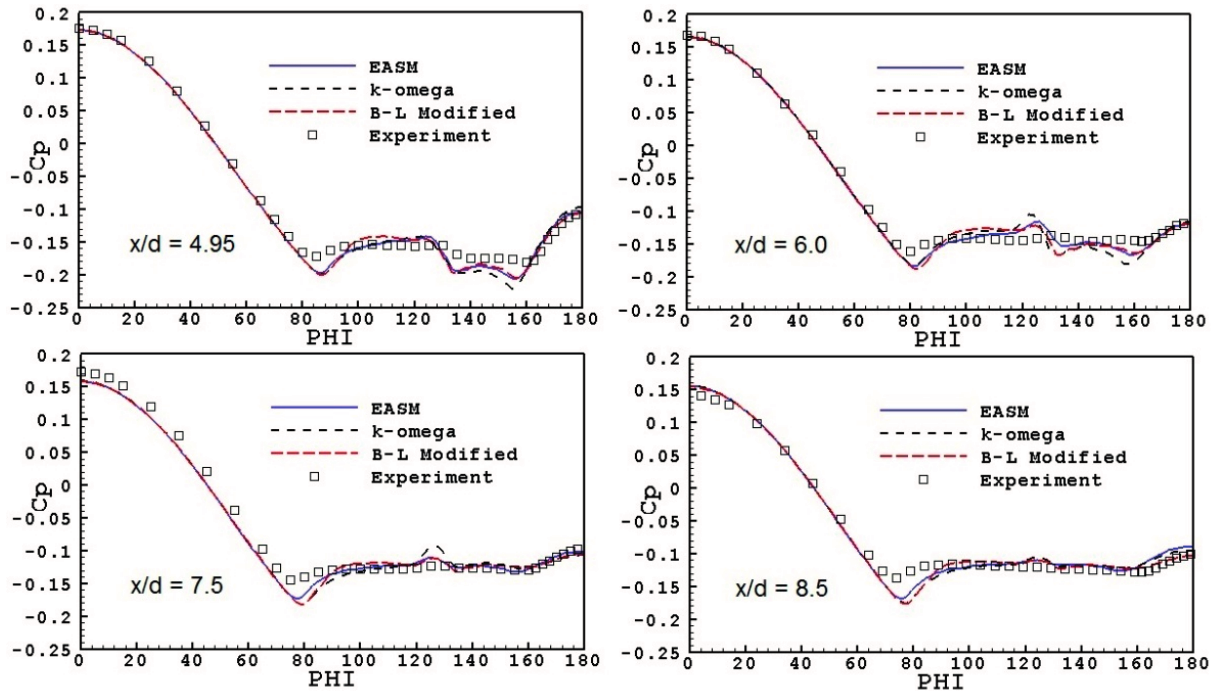
Figure 12. Ogive-cylinder: comparison of wall pressure coefficient at various cross sections. Reynolds number based on body